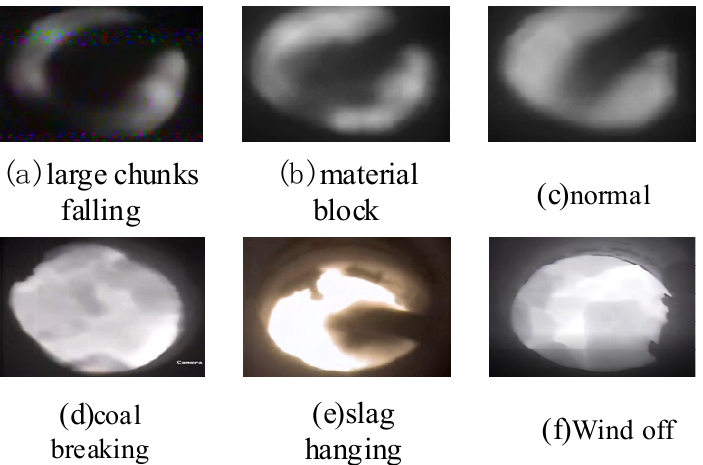
Figure 6. Blast furnace tuyere image category. ( a ) large chunks falling: large areas of darkening appear at the air outlet, and the large chunks are melted and disappear by the blast furnace, and the air outlet returns to brightness; ( b ) material block: gray coke in the blast furnace at the wind outlet for winding movement; ( c ) normal: the edge of the tuyere is smooth; there are no impurities in the tuyere and no dark area, and the dark area of the coal gun and coal injection is clearly visible; ( d ) coal breaking: the tuyere boundary is smooth, the tuyere is clear and bright, and there is no dark area produced by the coal injection; ( e ) slag hanging: there is uneven residue at the edge of the tuyere, and there is a small dark area at the slag hanging, and the gray level is large; ( f ) wind off: the coke rotation speed is slow, the carbon block gradually accumulates, and the wind is not bright and gradually darkens.